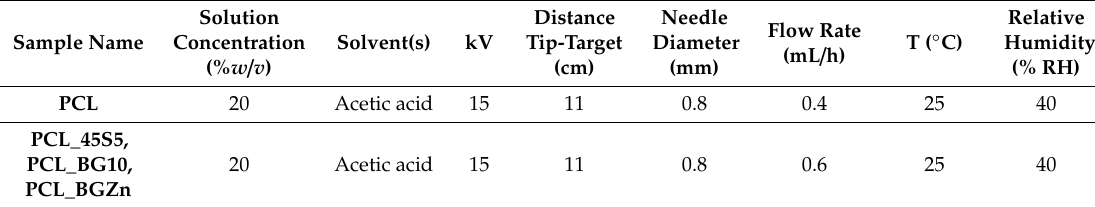
Table 2. Summary of parameters used for the di ff erent solutions during electrospinning